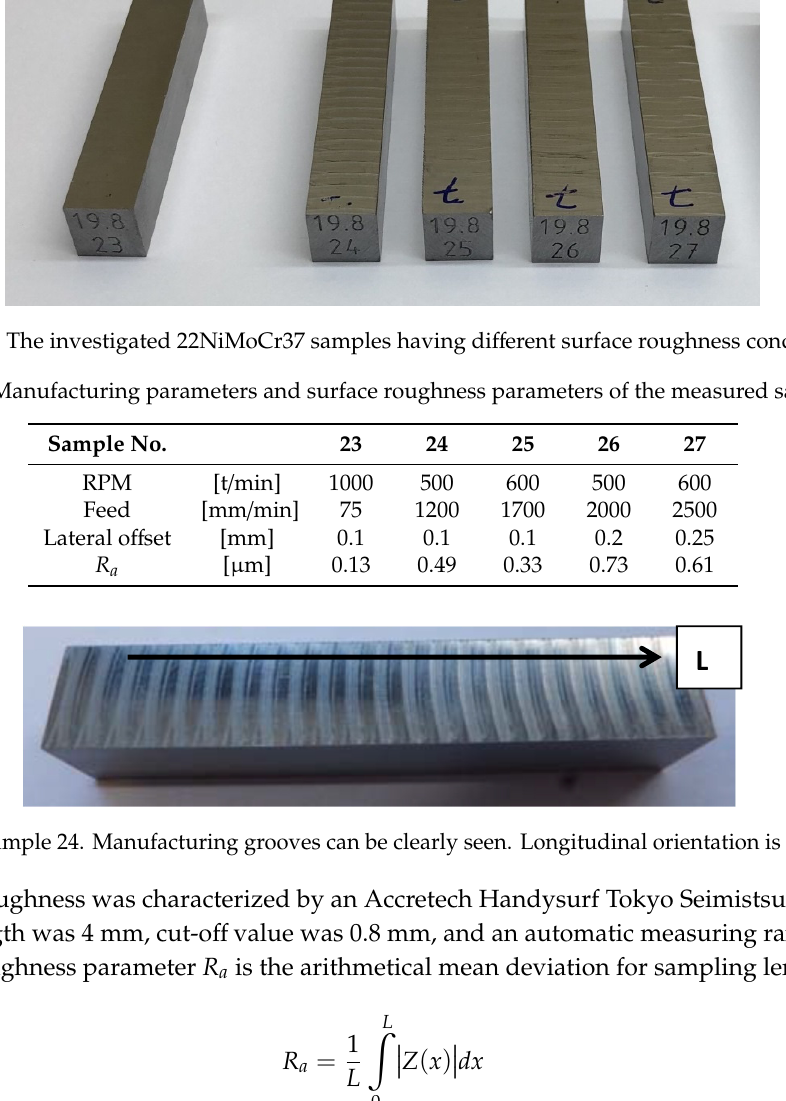
Figure 2. Sample 24. Manufacturing grooves can be clearly seen. Longitudinal orientation is indicated. Table 1. Manufacturing parameters and surface roughness parameters of the measured samples. Sample No.